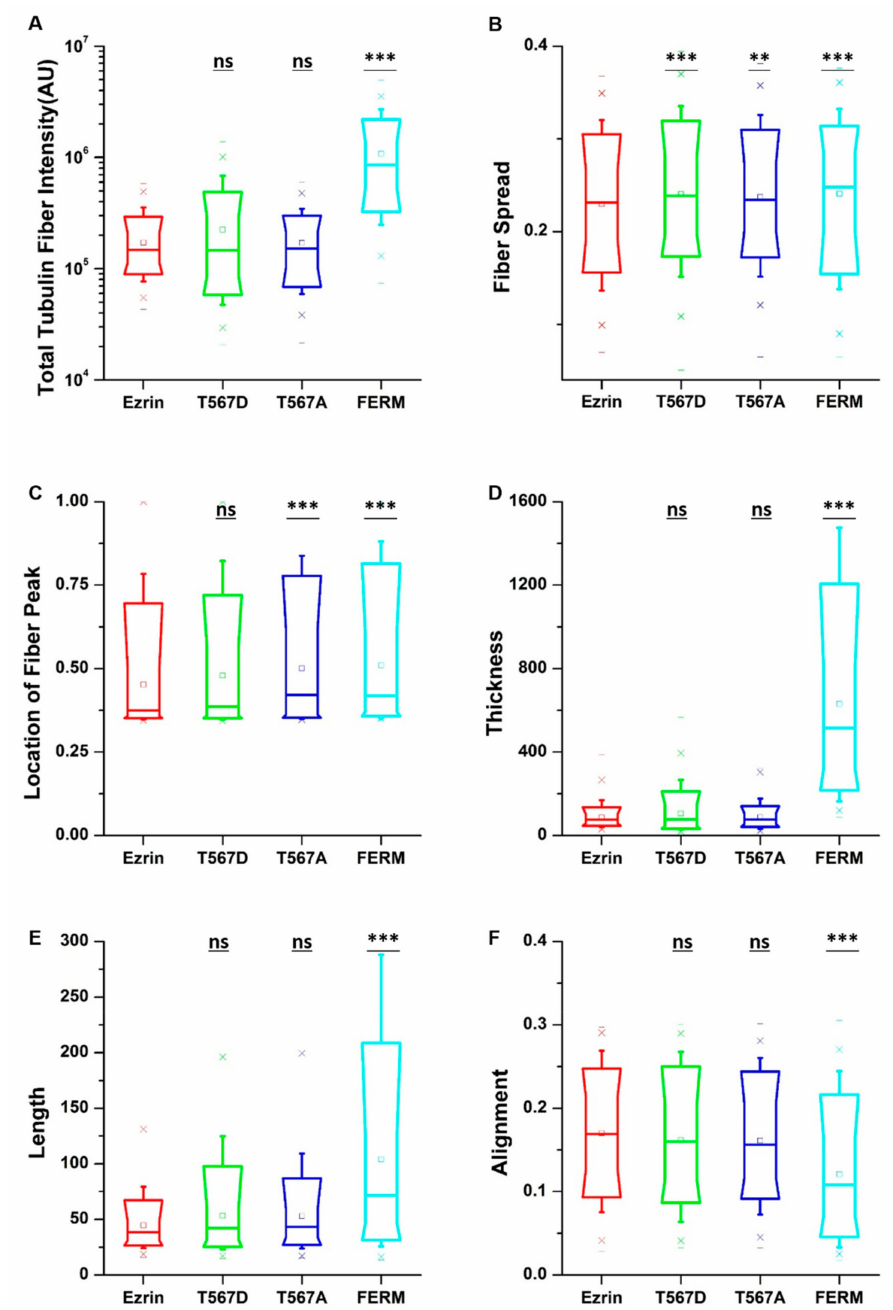
Figure 5. The e ff ect of ezrin mutations on the tubulin cytoskeleton. Box plots show the results of the total tubulin fiber intensity ( A ), fiber spread ( B ), location of the fiber peak ( C ), fiber thickness ( D ), fiber length ( E ), and fiber alignment ( F ). Box plots extend from the 10th to the 90th percentile, whiskers from the 5th to the 95th. A total of n = 559 (ezrin), n = 578 (ezrin T567D), n = 526 (ezrin T567A), and n = 408 (FERM) cells were analyzed from n = 6 repeats. Asterisks indicate a statistical di ff erence (** p < 0.01, *** p < 0.001, Dunnett’s test against wild-type